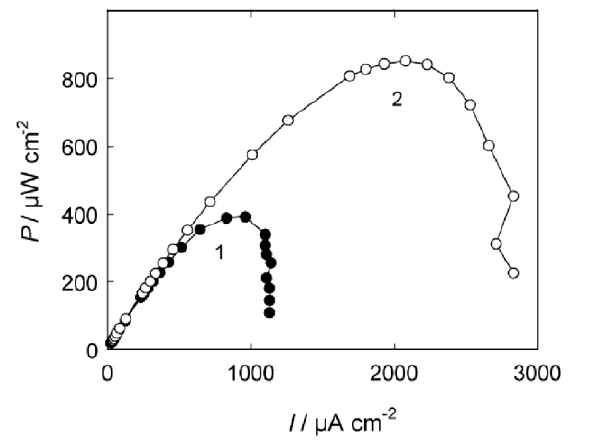
Figure 11. Dependence of power density on current density generated by one-compartment fructose-oxygen biofuel cell without (1) and with stirring (2) in presence of 200 mM fructose at 25 °C. Reprinted from reference [43] with permission of the PCCP Owner Societies.